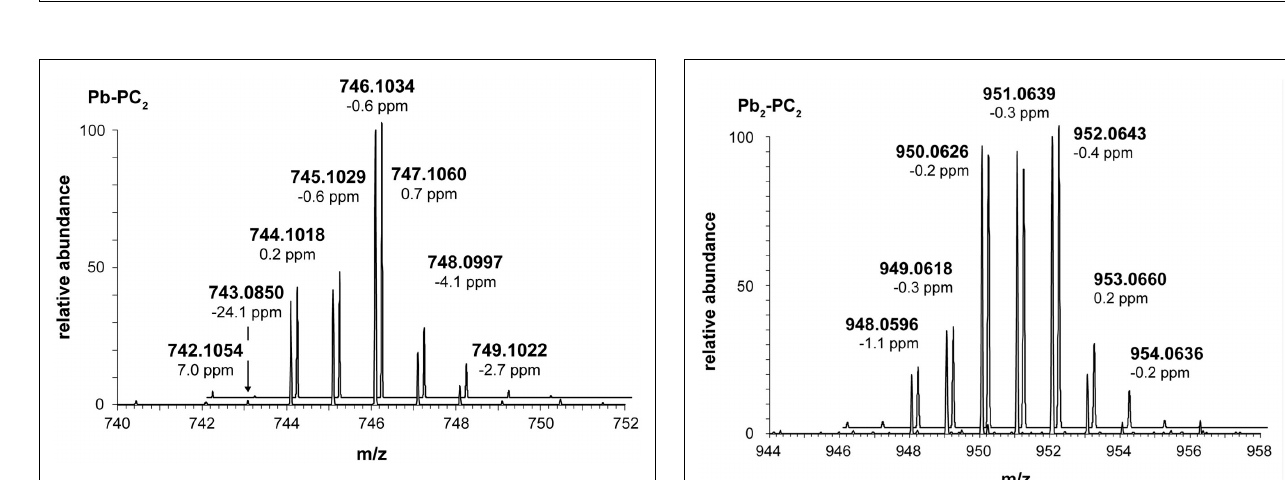
FIGURE 2 | Measured (front) and simulated spectrum (back) of the isotopic pattern of the [Pb–PC 2 ] + complex m / z 740–752. Isotopic distribution of Pb is identified in the peak distribution at m / z 742.11 ( 204 Pb, 1.5%), 744.10 ( 206 Pb, 23.6%), 745.10 ( 207 Pb, 22.6%), and 746.10 ( 208 Pb, 52.3%).